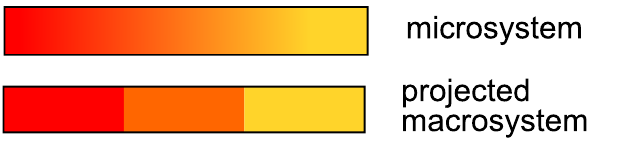
by the colors red, orange and yellow in the overall system at each point in time of the measurement. This situation is displayed in Figure 1.